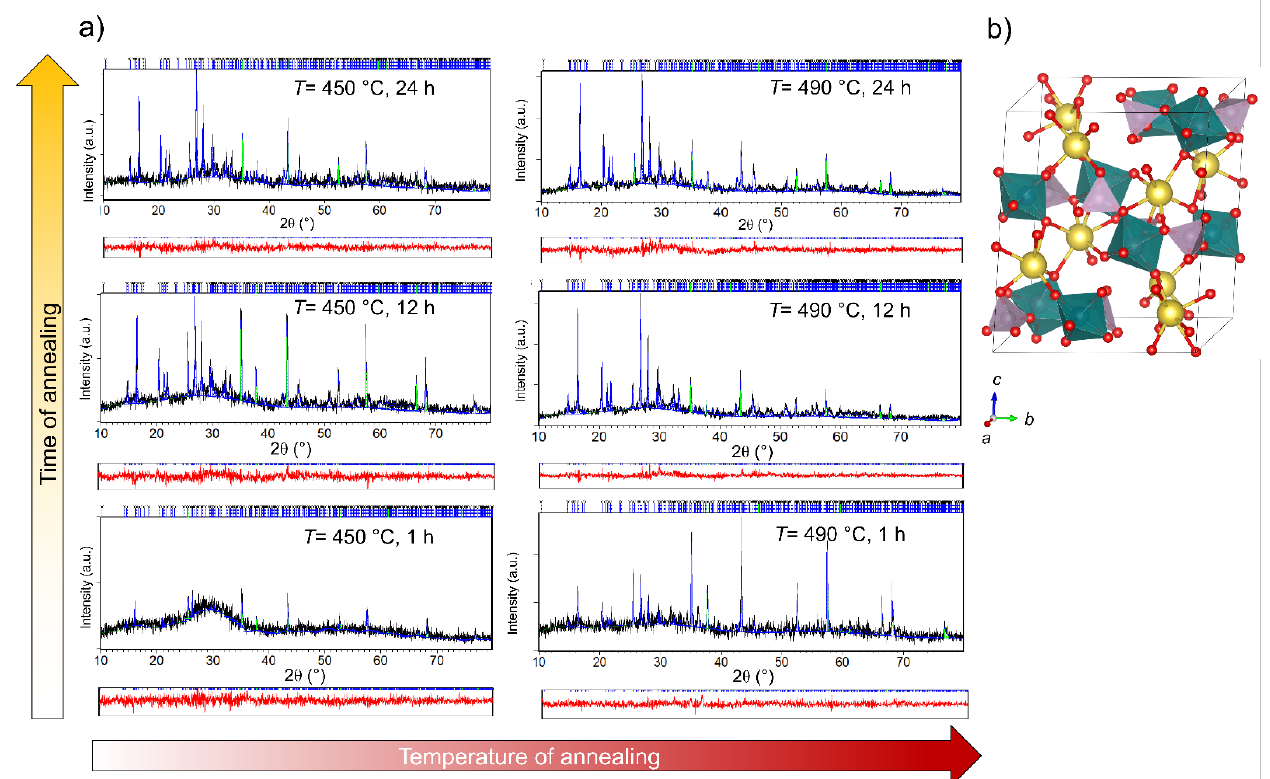
Figure 1. ( a ) Rietveld refinements of glass samples crystallized at 450 and 490 °C for 1, 12 and 24 h, mixed with powder of Al 2 O 3 used as an internal standard for amorphous phase quantification. Experimental data are given by the black line, the calculated pattern is shown in blue, and the red line below represents the difference curve. Blue vertical marks show the positions of diffraction lines belonging to NaMoO 2 PO 4 phase, while the positions of Al 2 O 3 lines are given as green vertical marks. ( b ) The structure of NaMoO 2 PO 4 : Mo is given in teal, P in pink, Na in yellow and O in red.